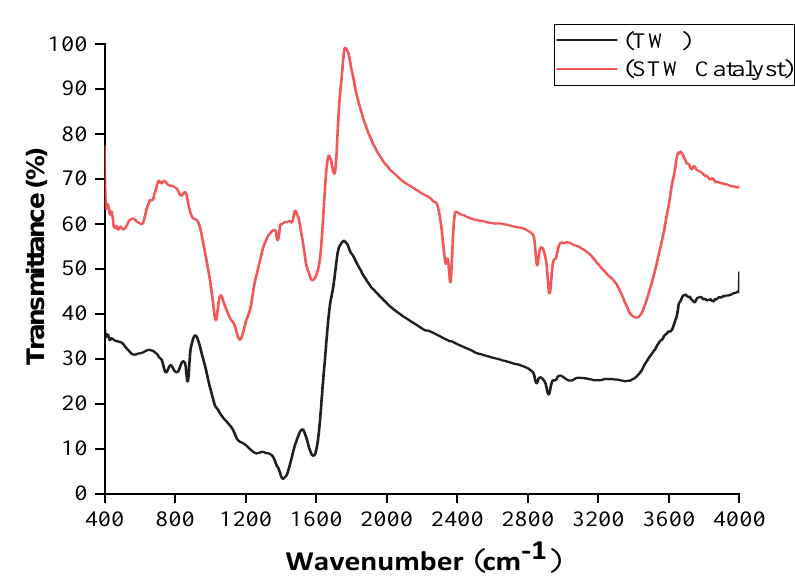
Figure 1. FT-IR spectra of tea waste (TW) char and sulfonated tea waste (STW) catalyst.